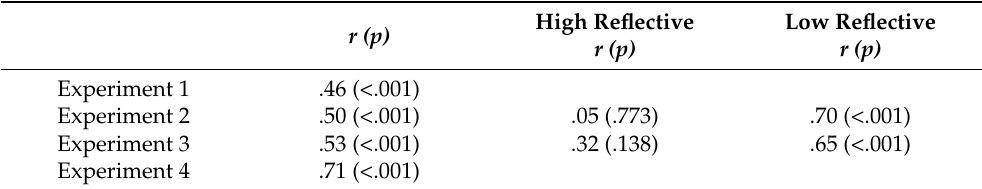
Table 1. Correlation of base-rate responses between standard and rule-inadequate problems (Experi- ments 1 to